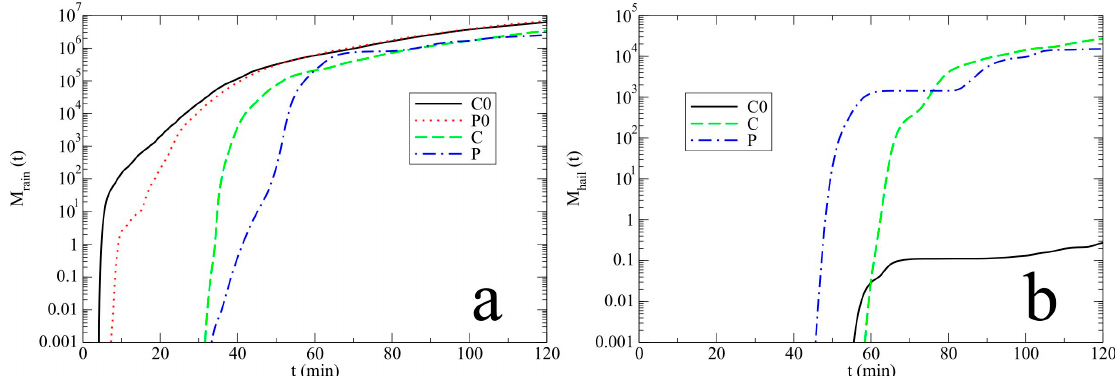
Figure 3. The amounts (tonnes) of ( a ) surface rain and ( b ) hail as a function of time for experiments for clean air without drizzle (C0) and with drizzle (C) and polluted air without drizzle (P0) and with drizzle (P). Atmosphere 2018 , 9 , 13